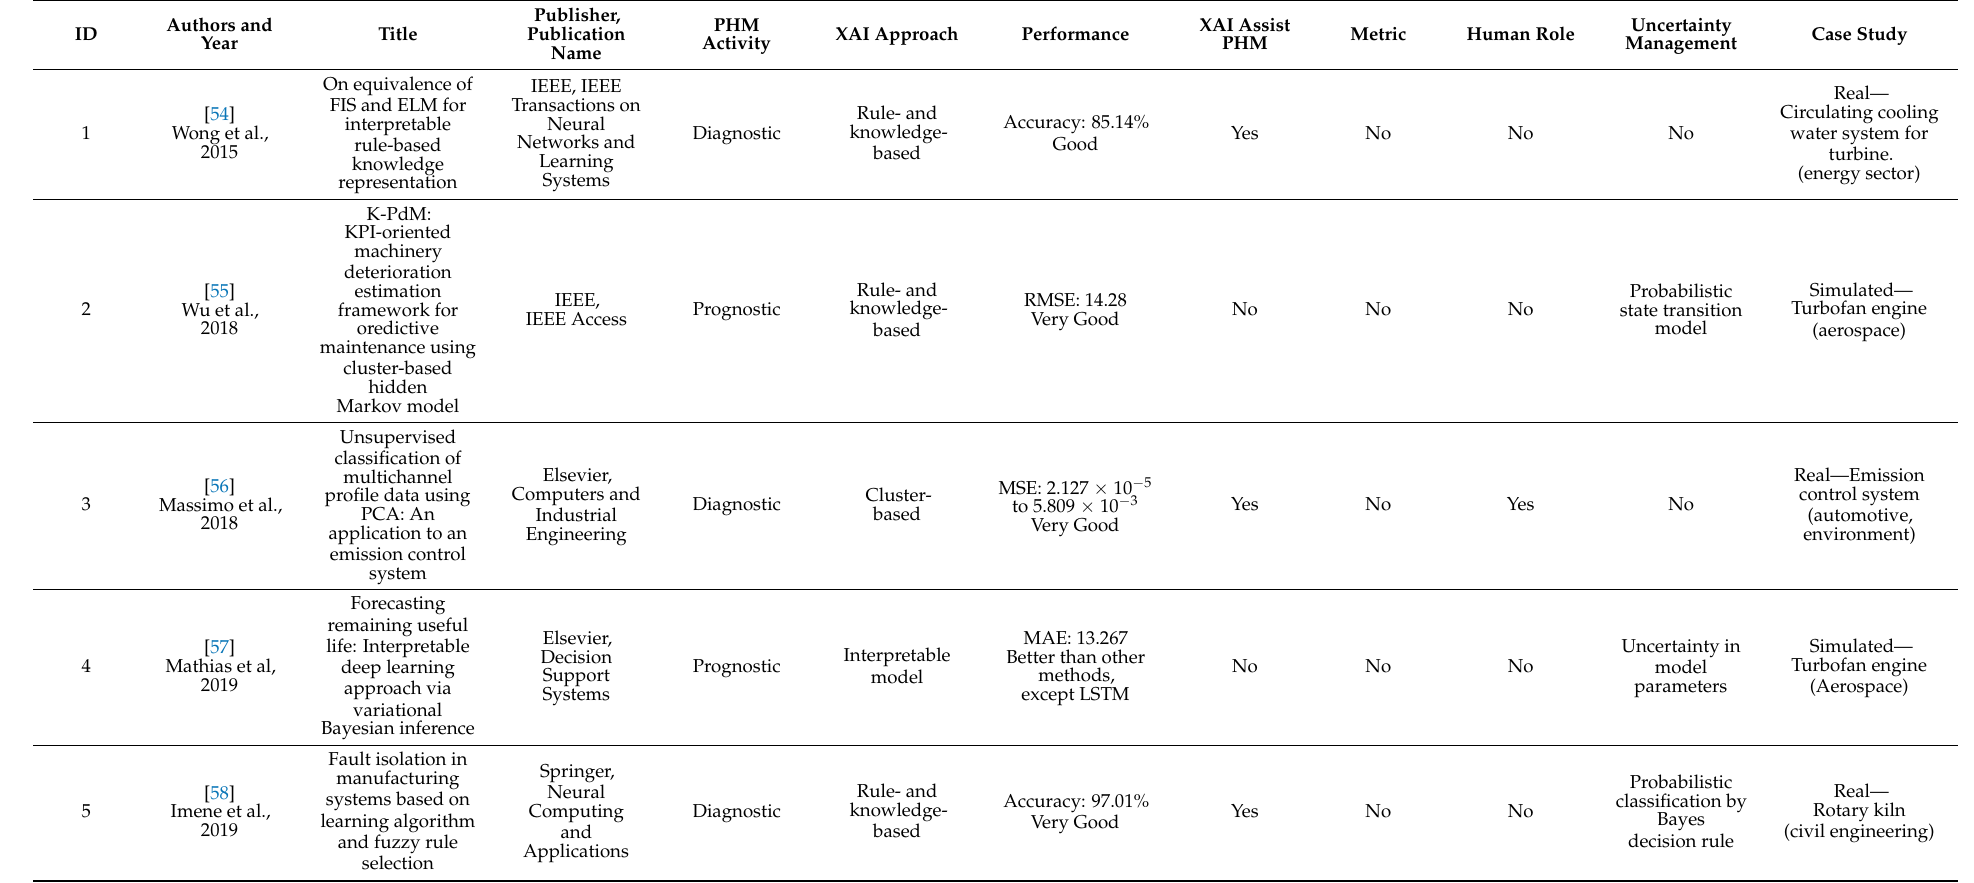
Table A1. Analysis results of selected